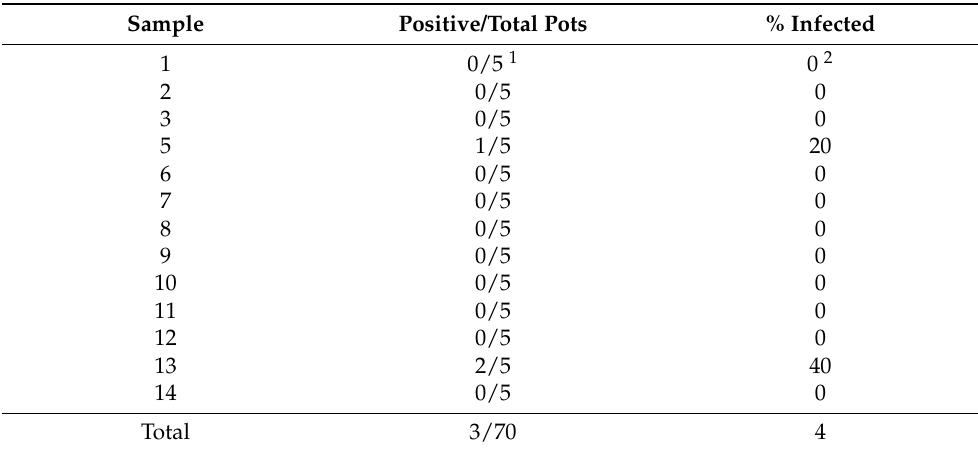
Table 2. Bulk sampling of 70 CGMMV infested pots containing watermelon plants and tested for the presence of CGMMV.